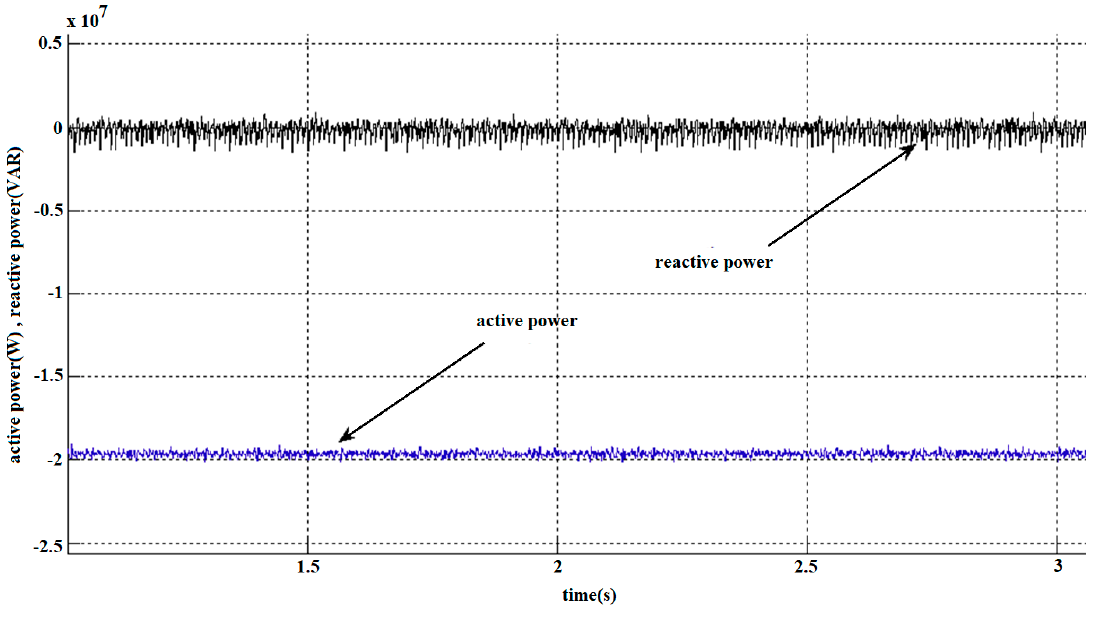
Figure 22. Active and reactive power waveforms of wind farm.